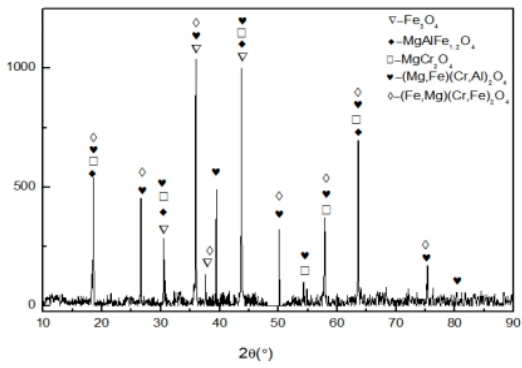
Figure 1. XRD pattern of chromite concentrate.